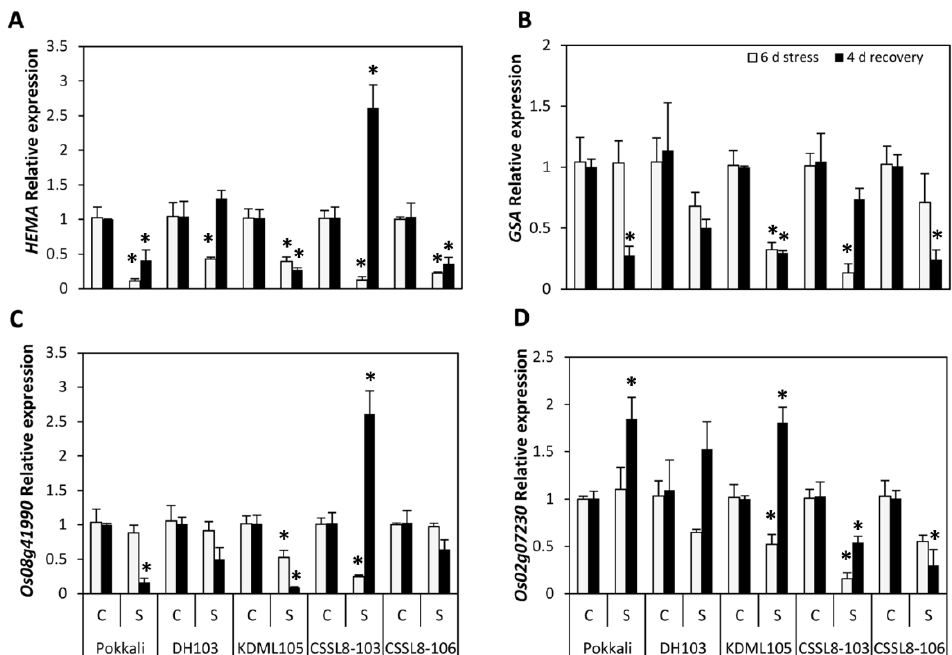
Figure 2. Expression of genes involved in chlorophyll synthesis ( A ) HEMA , ( B ) GSA , ( C ) Os08g41990 , ( D ) Os02g07230 of rice plants under control and salt stress for 6 days (light gray bars) and after recovery for 4 days (black bars). The histogram shows relative abundance of mRNA for each gene and each treatment after normalization with OsActin . C, control; S, salt stress. For a description of the genotypes, see Figure 1. The asterisk shown in each bar indicates statistically significant di ff erence in gene expression ( p ≤ 0.05) between control and salt stress in each period. All relative expression of each gene was normalized to the control condition in the same